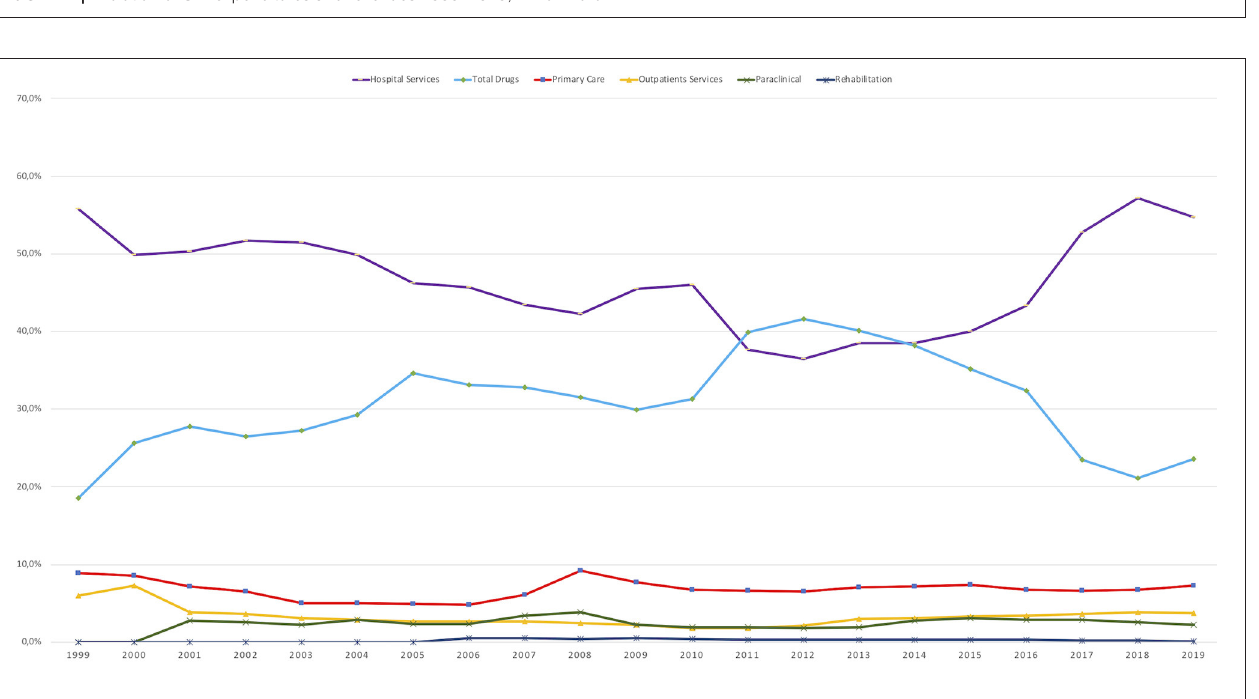
FIGURE 1 | Evolution of SHI expenditures and revenues 1999–2019, million Euro.